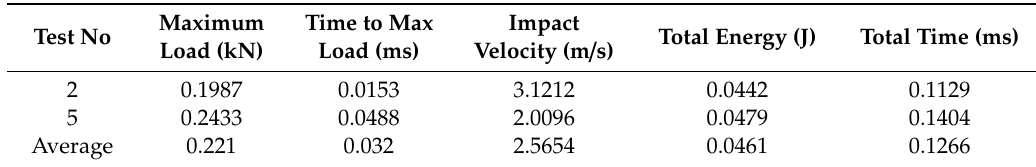
Table 2. Impact test results of dry